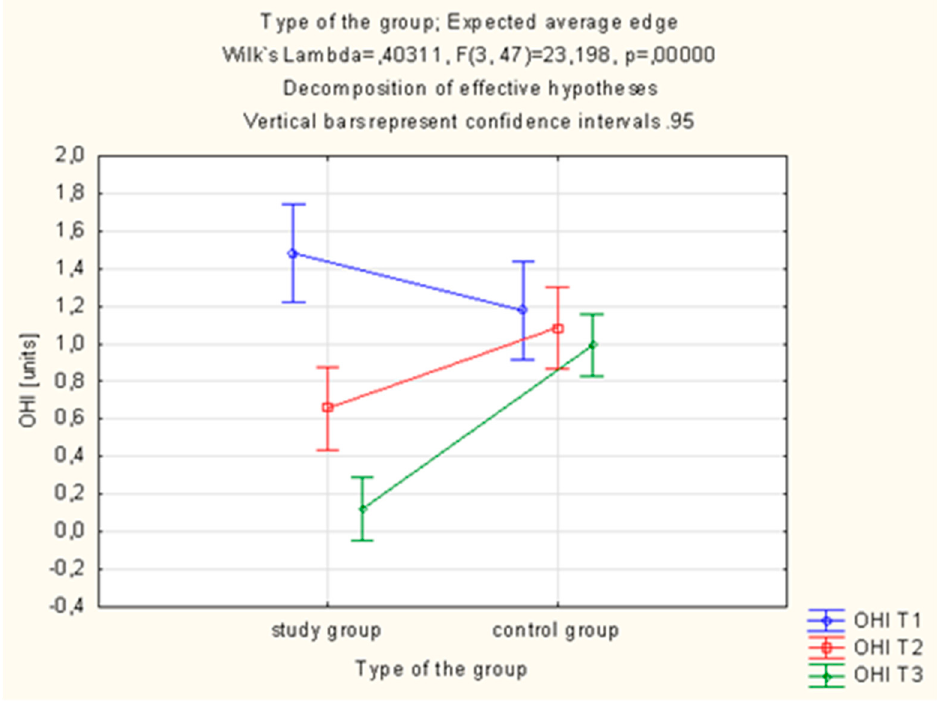
Figure 3. ANOVA Estimated Marginal Means for the simplified oral hygiene index (OHI-s).